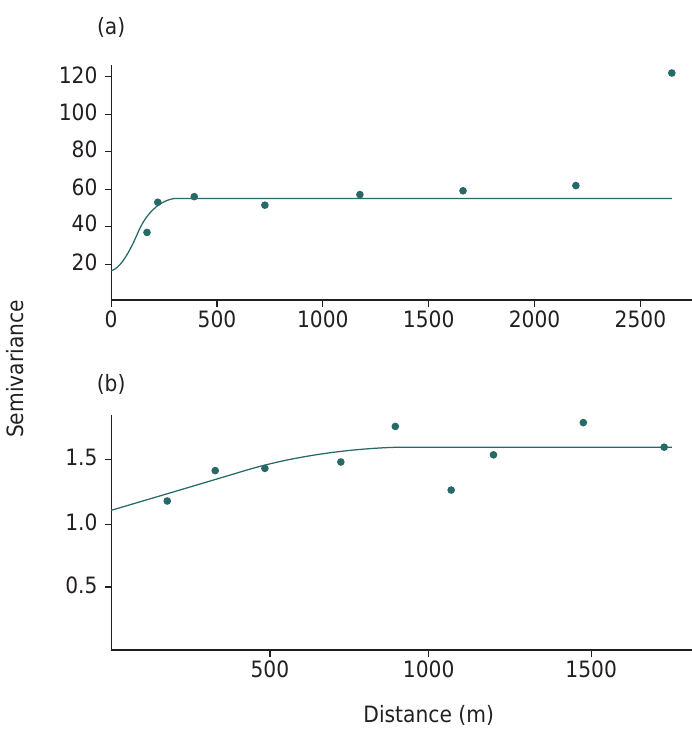
Figure 3. Semivariograms fitted to sand (a) and soil organic carbon contents